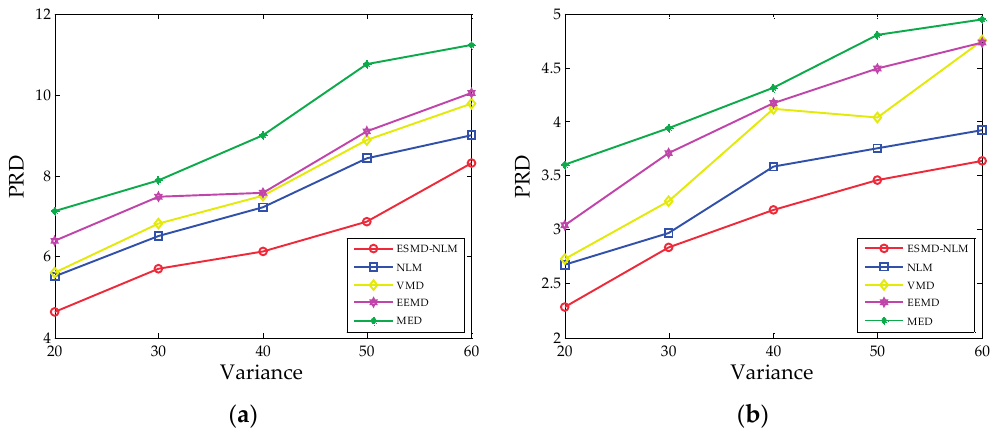
Figure 6. The PRD for the two groups of simulated ECG signals filtered by all evaluated methods when the variance σ 2 of Gaussian noise is 20, 30, 40, 50 and 60, respectively. ( a ) The first group; ( b ) the second group.